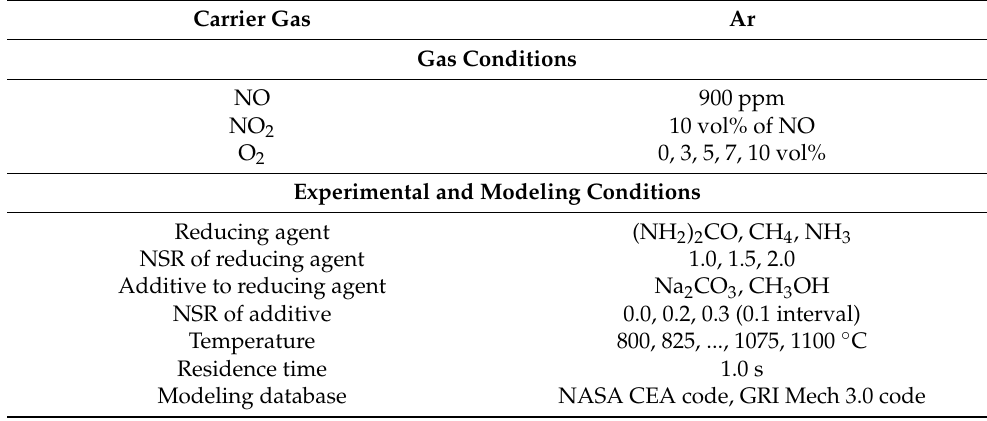
Table 1. Experimental and modeling